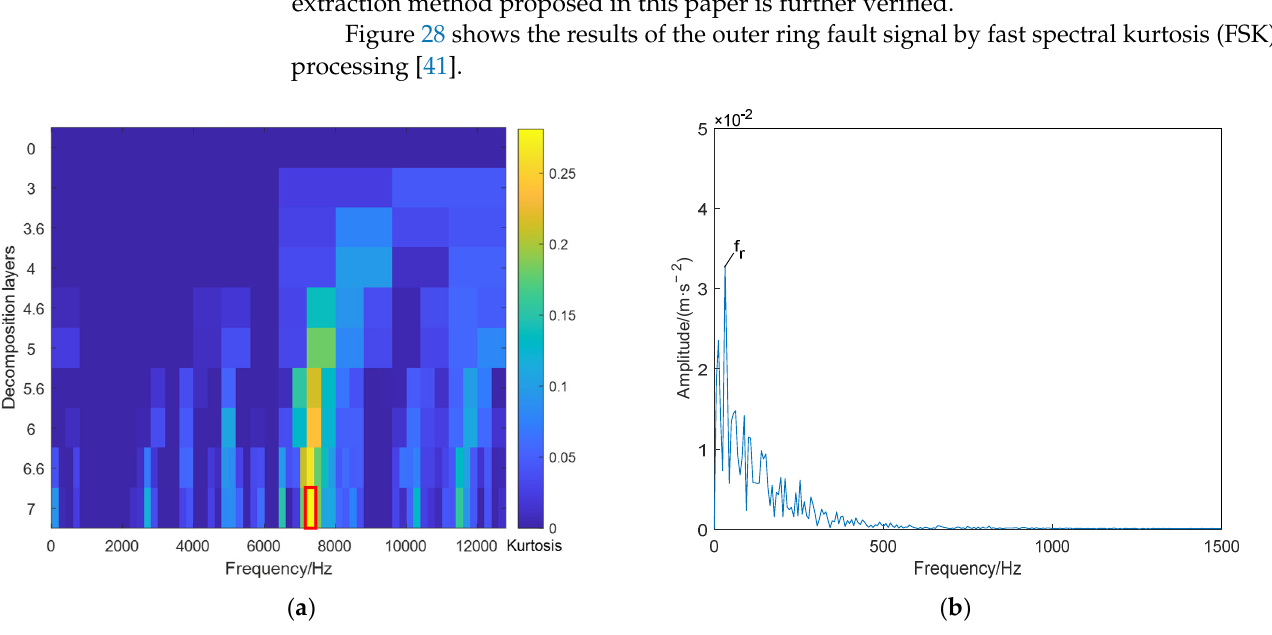
Figure 27. Time-domain waveform and envelope spectrum after MCKD processing: ( a ) time-do- main graph after MCKD processing; ( b ) envelope spectrum after MCKD processing.